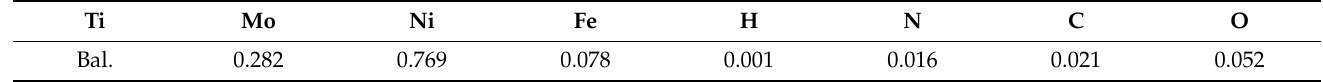
Table 1. Chemical composition of TA10 ingot (wt.